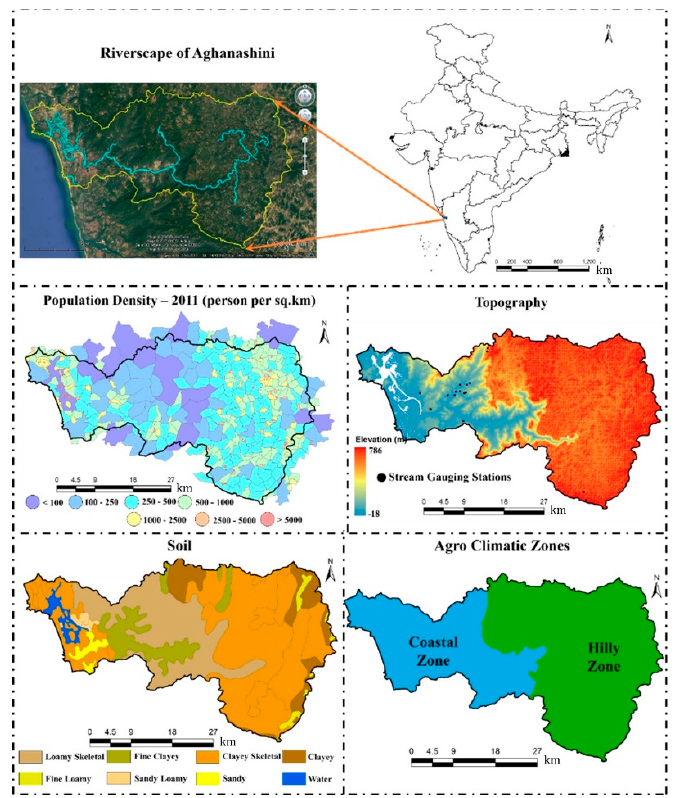
Figure 1. Aghanashini River catchment—population density, topography, soil, and agro-climatic Figure zones.